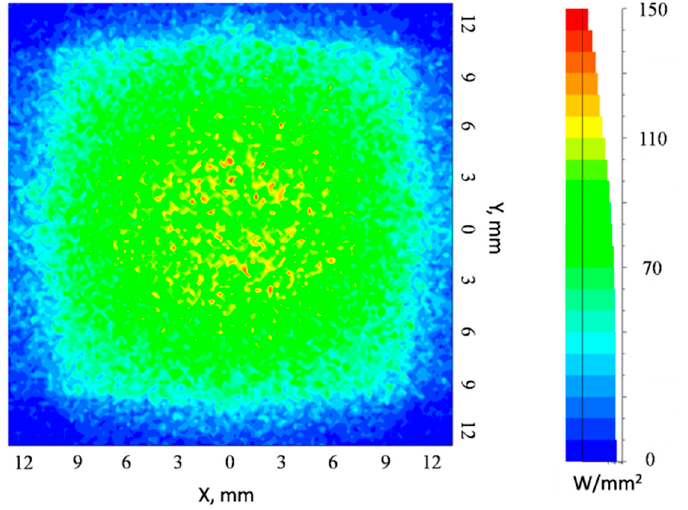
Figure 12. The distribution of concentrated light over the one end of the bundle of optical fibers.